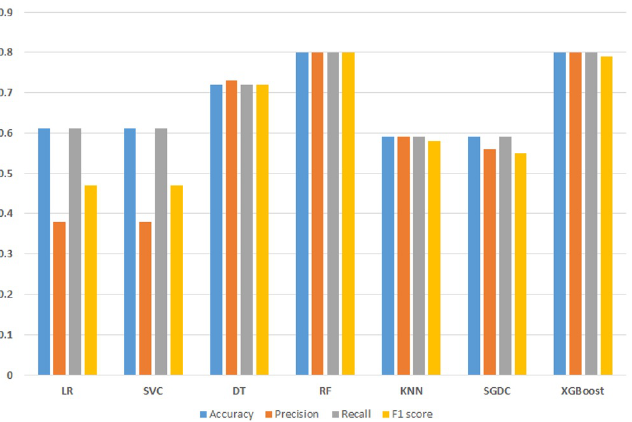
Figure 7. Results of machine learning models using KNN imputer to handle missing values.